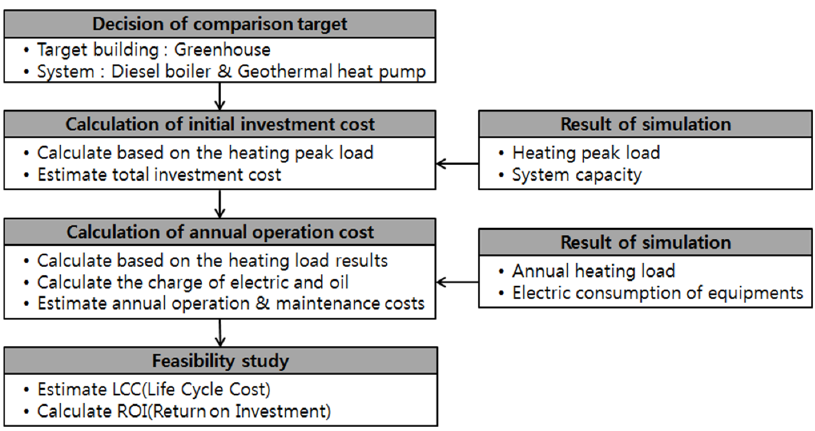
Figure 9. Schematic diagram of economic analysis.